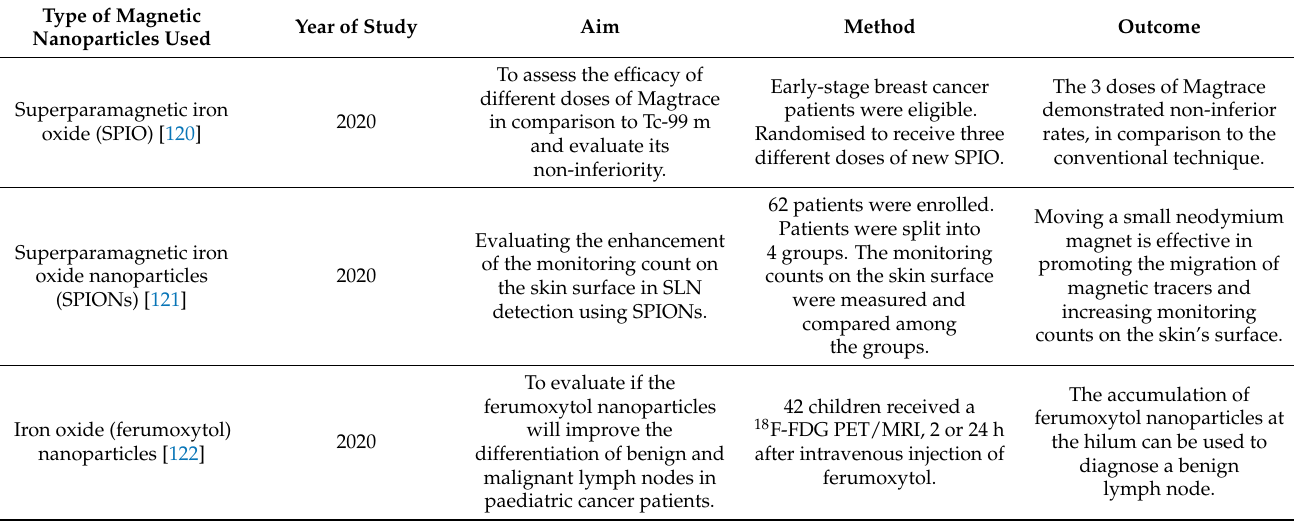
Table 3. An outline of various clinical trials on MNPs, including their aims, methods, and outcomes. Type of Magnetic Nanoparticles